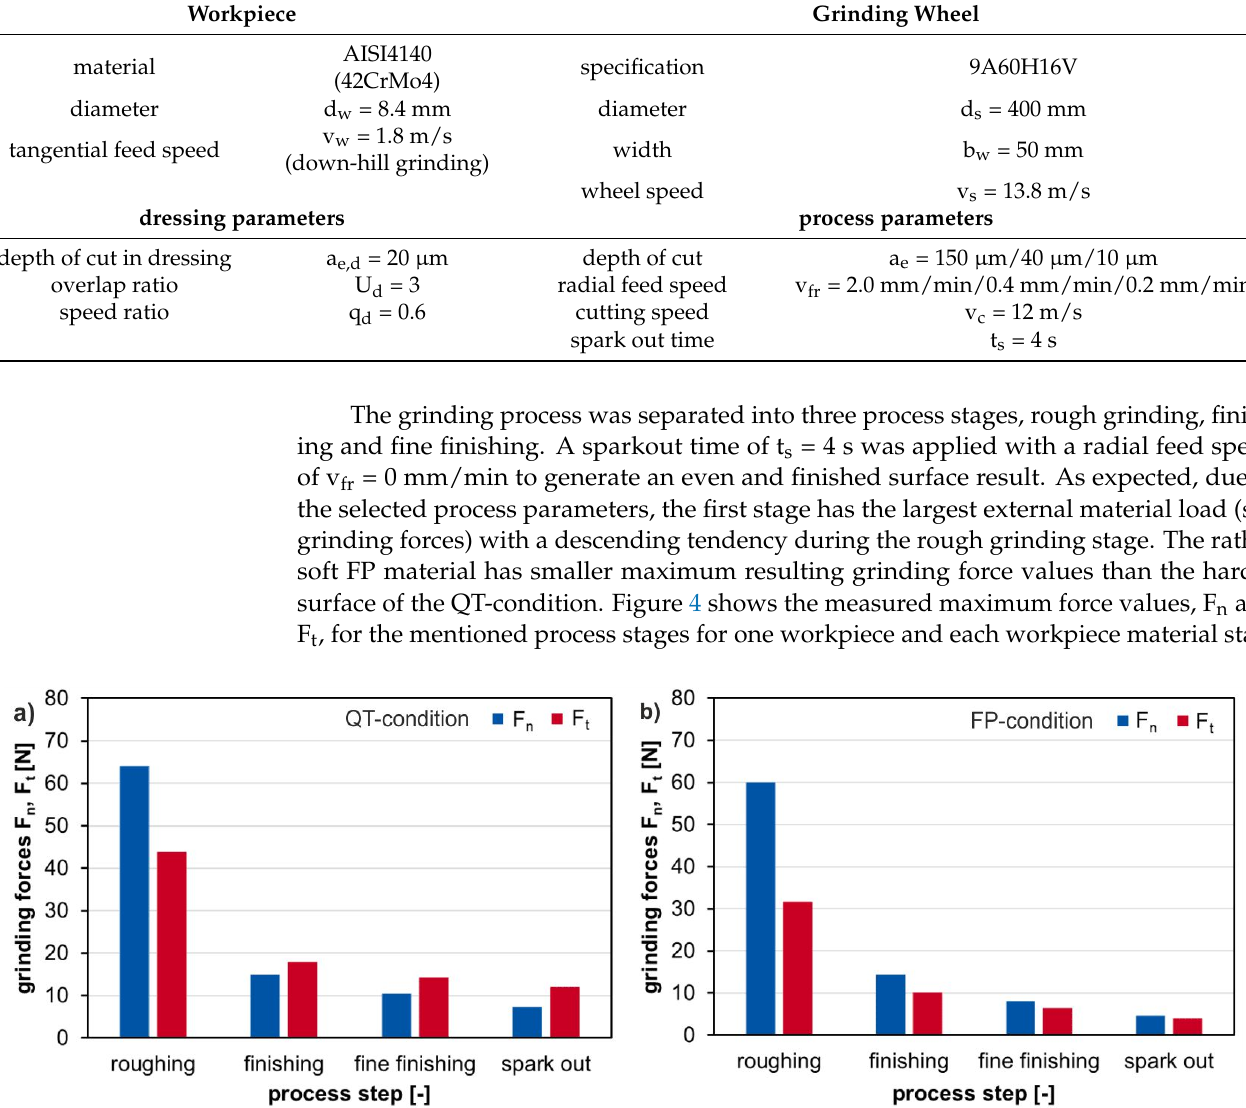
Figure 4. Force measurement results for ( a ) a specimen in QT-condition ( b ) a specimen in FP-condition.